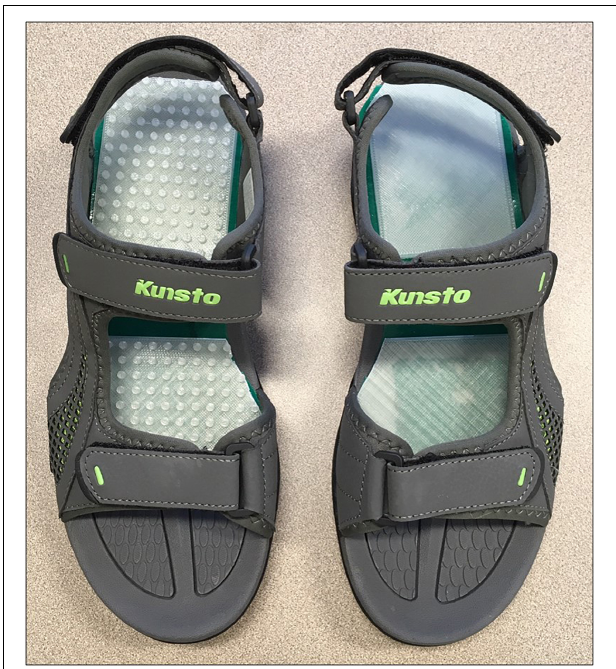
FIGURE 2 | Insole intervention. Standardized walking sandals were worn by all participants. At baseline, participants were randomly assigned to either textured insoles (example on left) or smooth insoles (example on right). At follow-up, participants wore the walking sandals without